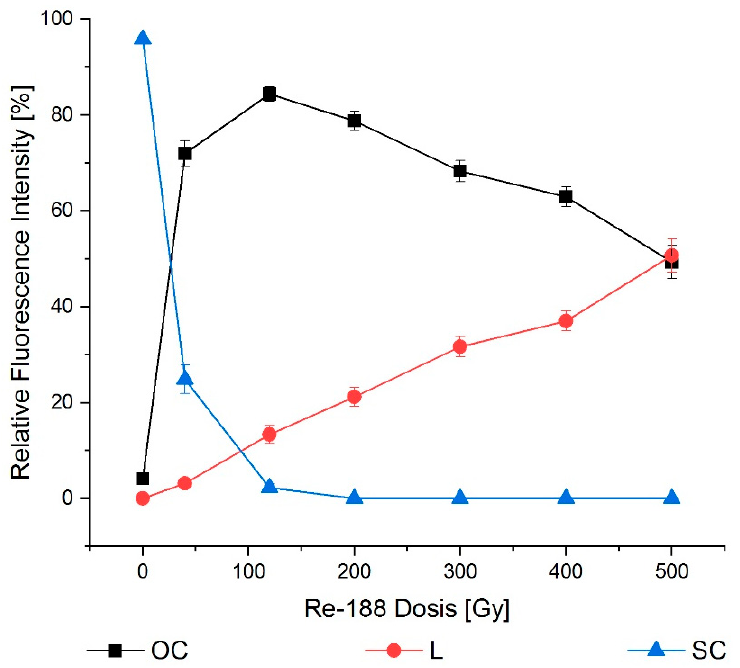
Figure 7. Dose–effect relation for Re-188 after 24 h incubation. The mere radiotoxicity of Re-188 had an influence on all conformations. Supercoiled (SC) transformed into open circular (OC) and eventually into linear (L) conformations for higher doses. The error bars show the SEM.